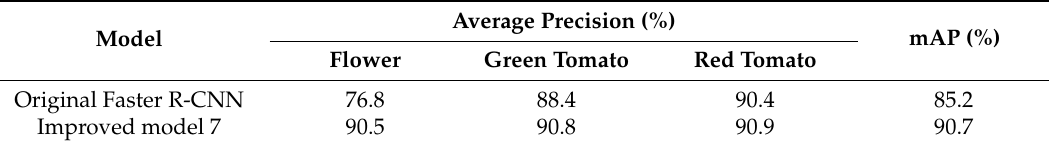
Table 2. Model average precision and mean average precision.